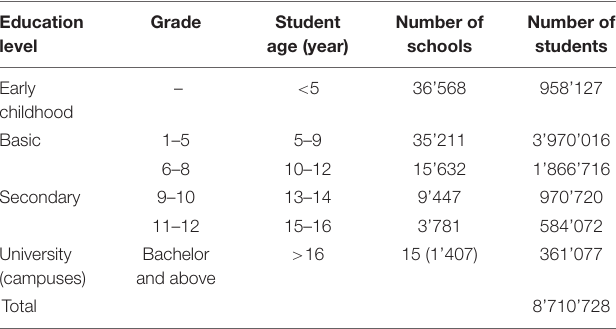
TABLE 1 | Education system in Nepal and key numbers, according to Department of Education [DOE]